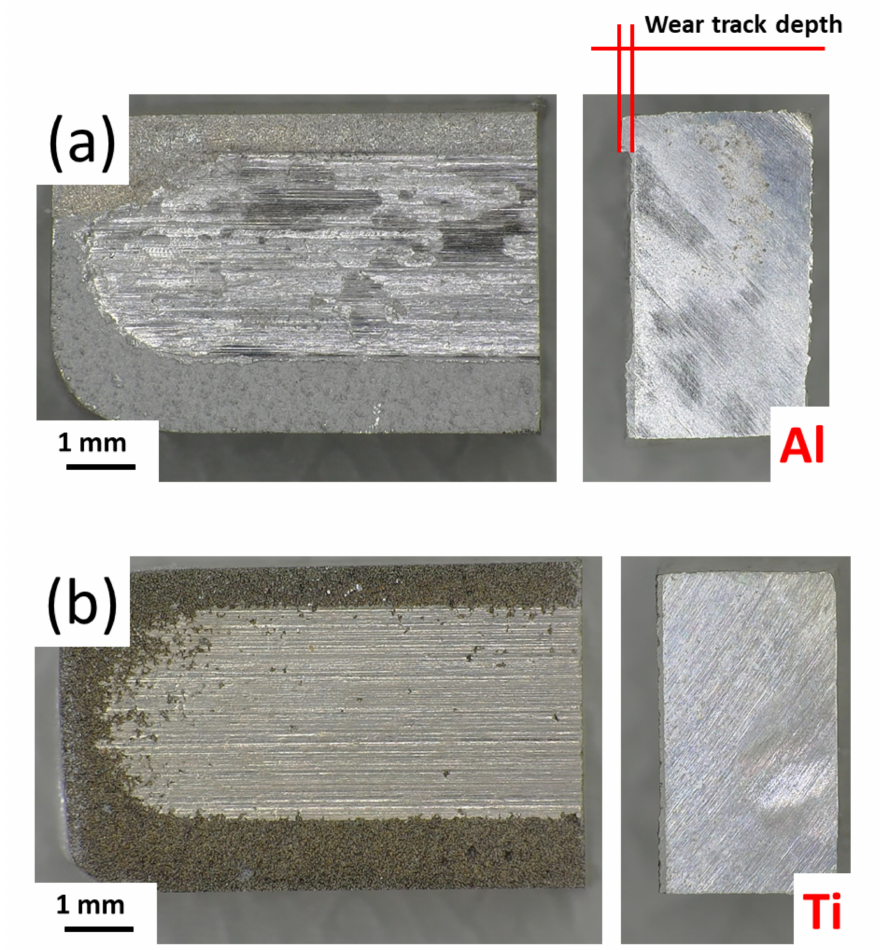
Figure 12. Top and cross-sectional view of Al_1.5 ( a ) and Ti_1.0 ( b ) coatings after pin on plate wear